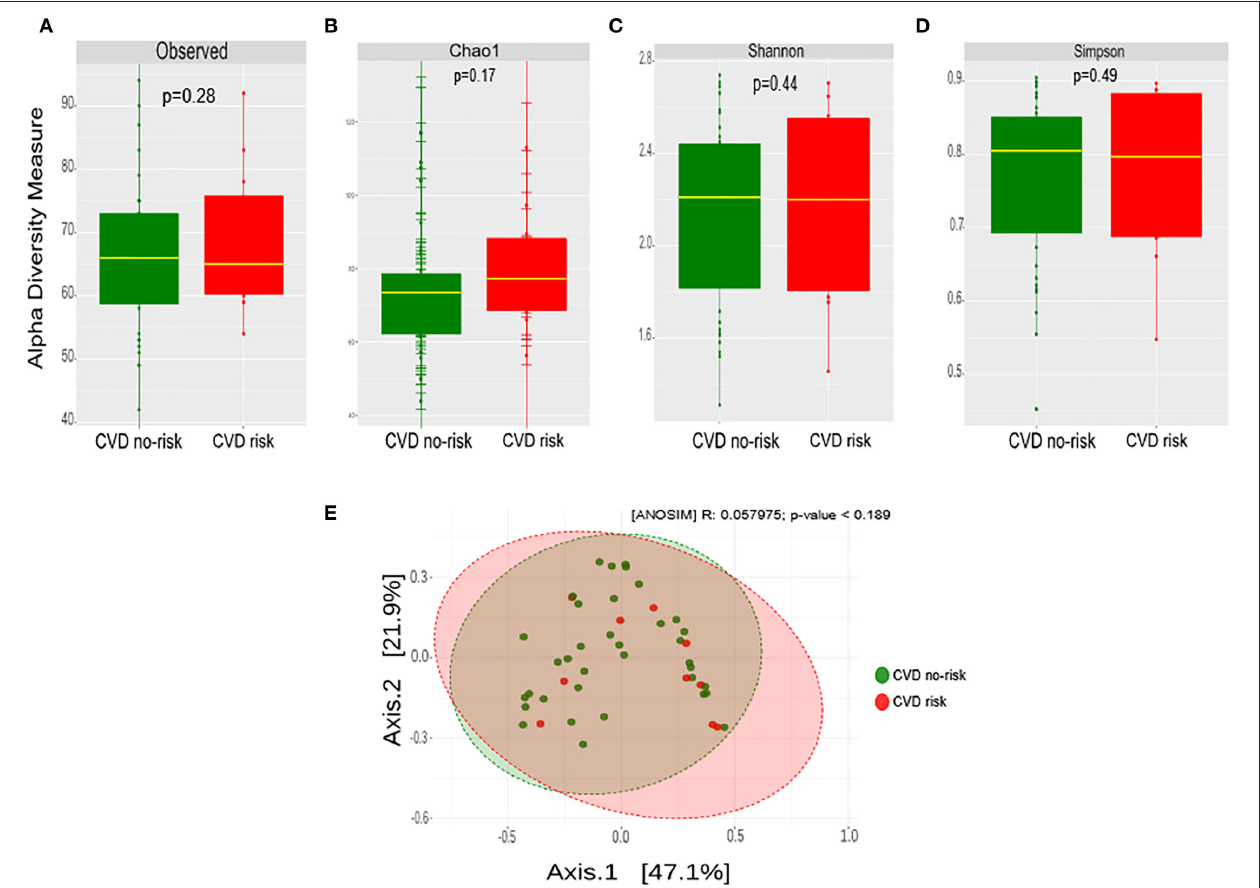
FIGURE 3 | Gut microbial diversity in the CVD no-risk and CVD risk groups. (A–D) Alpha diversity was measured by the four commonly used methods, Observed, Chao1, Shannon, and Simpson. The boxplots show median and interquartile (IQR) range and whiskers extending to the most extreme points within 1.5-fold IQR. (E) Beta diversity index was measured by the Bray-Curtis method using principle coordinate analysis of the relative abundance of OTUs. The two-variances explained by Axis.1 and Axis.2 are 47.1 and 21.9%, respectively. ANOSIM, analysis of similarity; CVD no-risk, N = 36; CVD risk, N = 10. P < 0.05 was considered statistically significant using Student’s t-